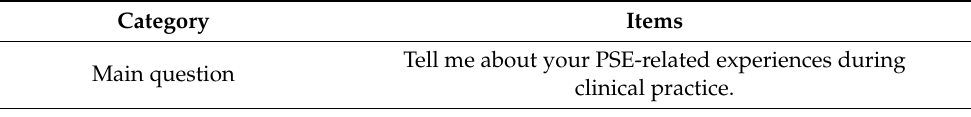
Table 1. Examples of questions related to patient safety error (PSE) experiences used during the interview sessions with the